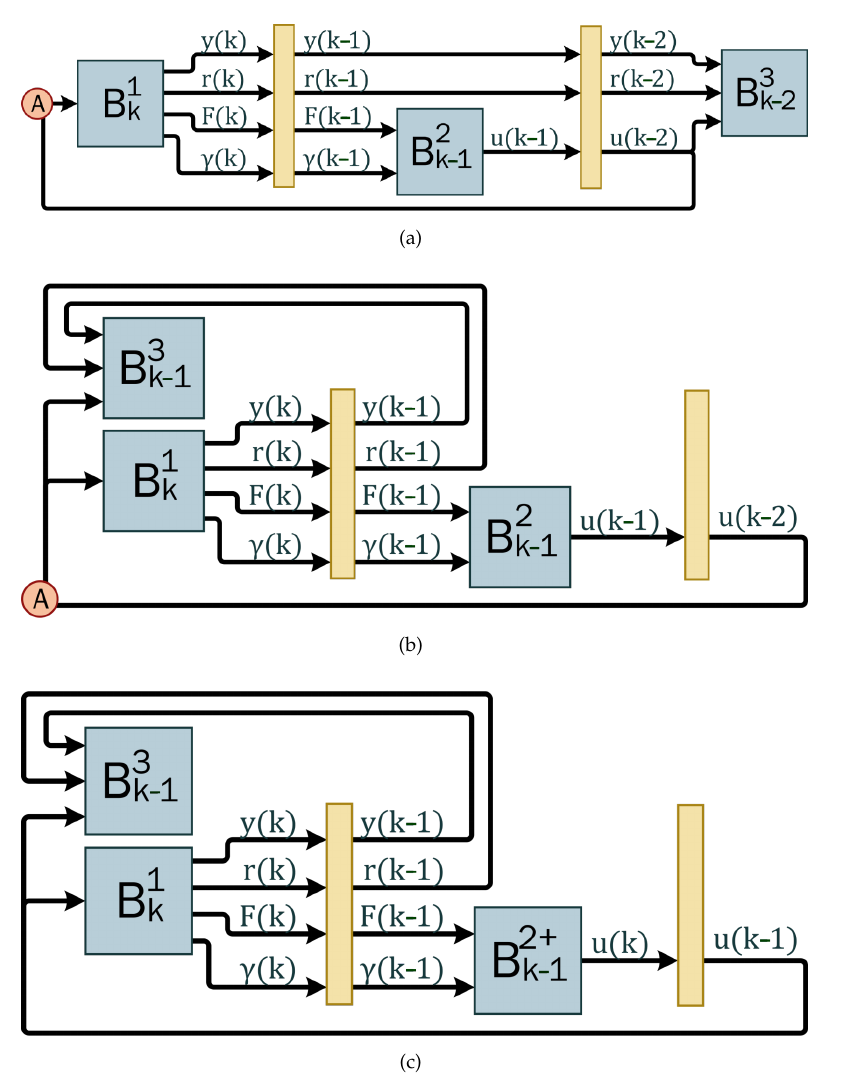
Figure 6. Optimization methodology: ( a ) Executing a bundle per step. ( b ) Executing Bundle 1 and Bundle 3 in the same step. ( c ) Executing Bundle 1 and Bundle 3 in the same step, and implementing